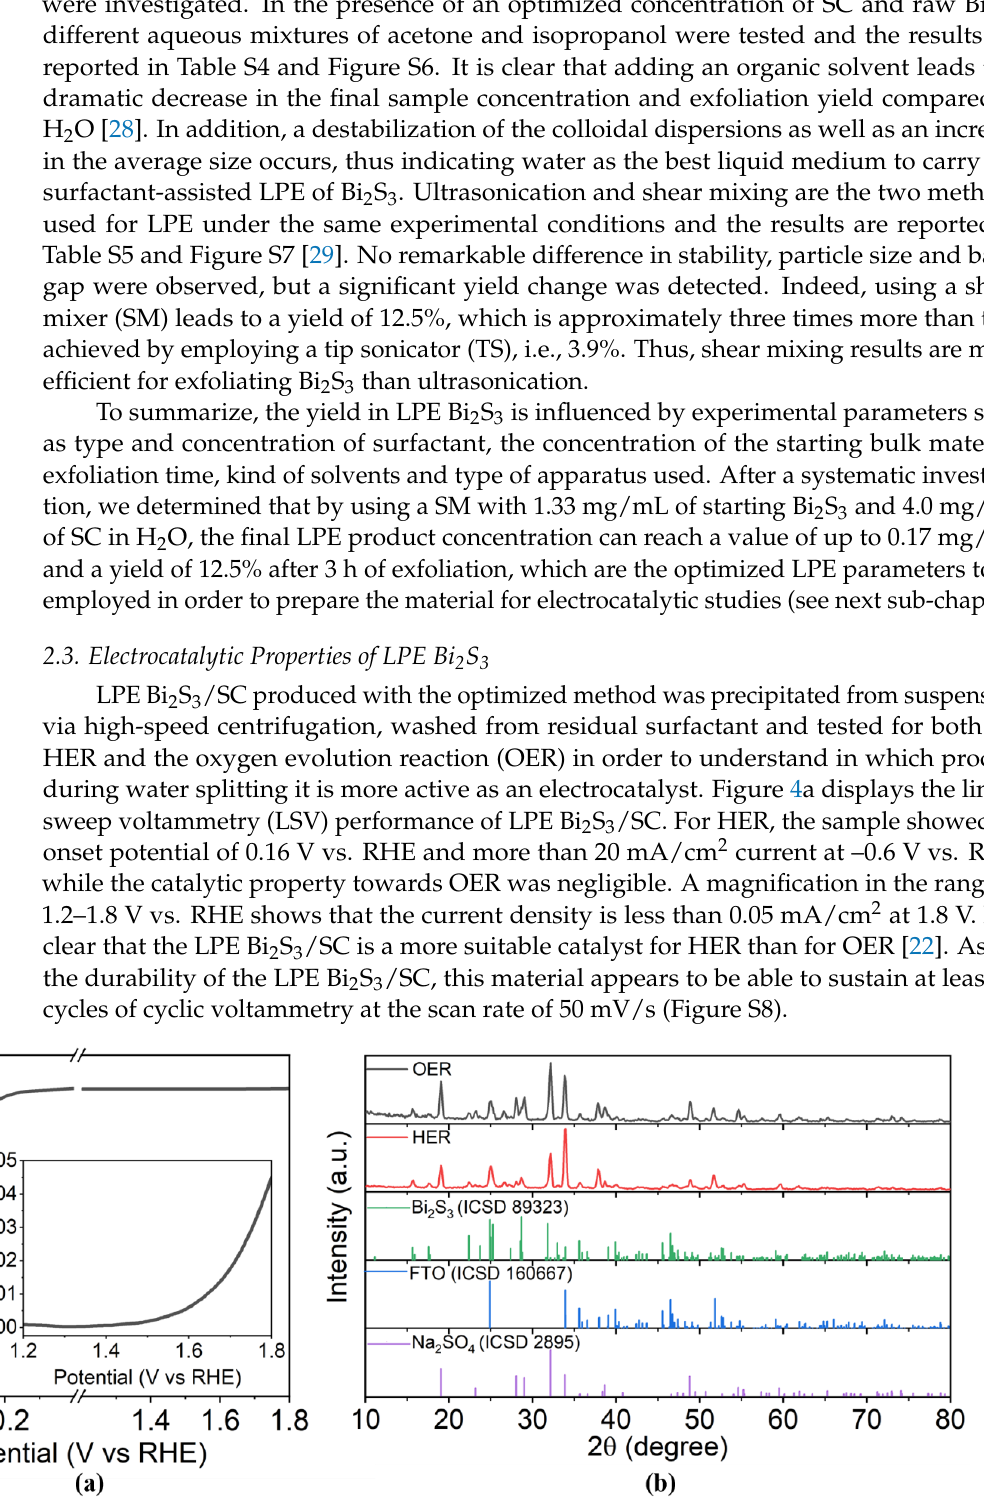
Figure 4. ( a ) Polarization curve (scan rate 10 mV/s) of LPE Bi 2 S 3 /SC NSs (1.61 mg/cm 2 ) for HER and OER electrocatalysis at pH 7 (Na 2 SO 4 0.5 M). Inset exhibits the magnification of the polarization curve of 1.2-1.8 V vs. RHE; ( b ) GI-XRD patterns of LPE Bi 2 S 3 /SC after HER and OER. Reference patterns of orthorhombic Bi 2 S 3 (ICSD 89323), FTO (ICSD 160667) and Na 2 SO 4 (ICSD 2895) are reported for the sake of clarity.